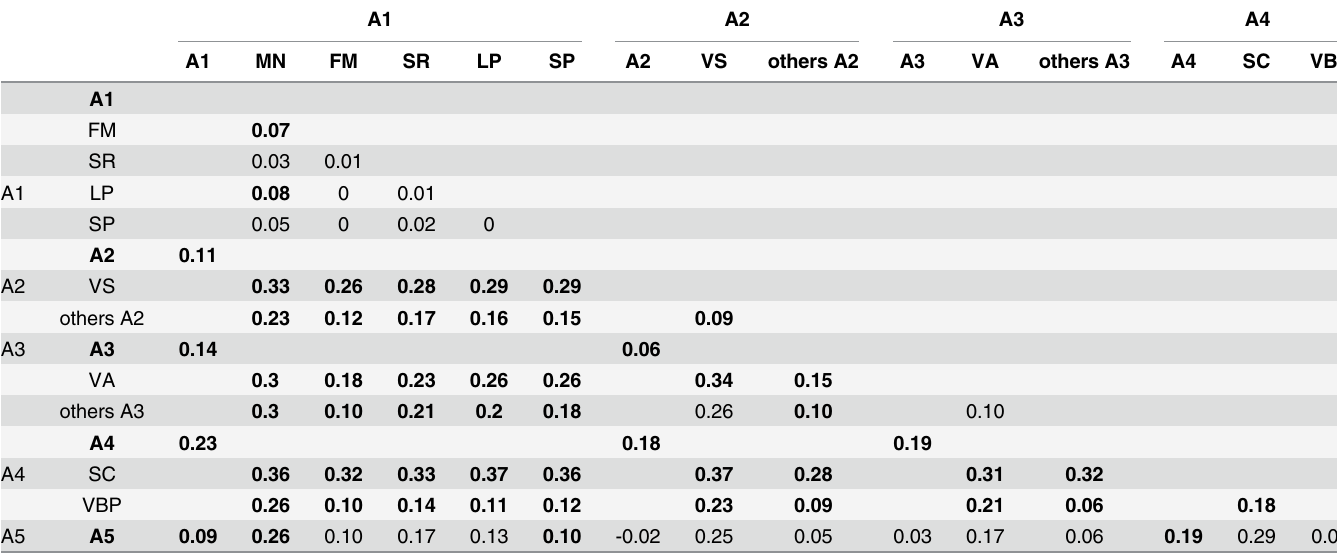
Table 2. PHI PT values obtained from pairwise comparison between study areas (A1 – A5) and between villages within each area.